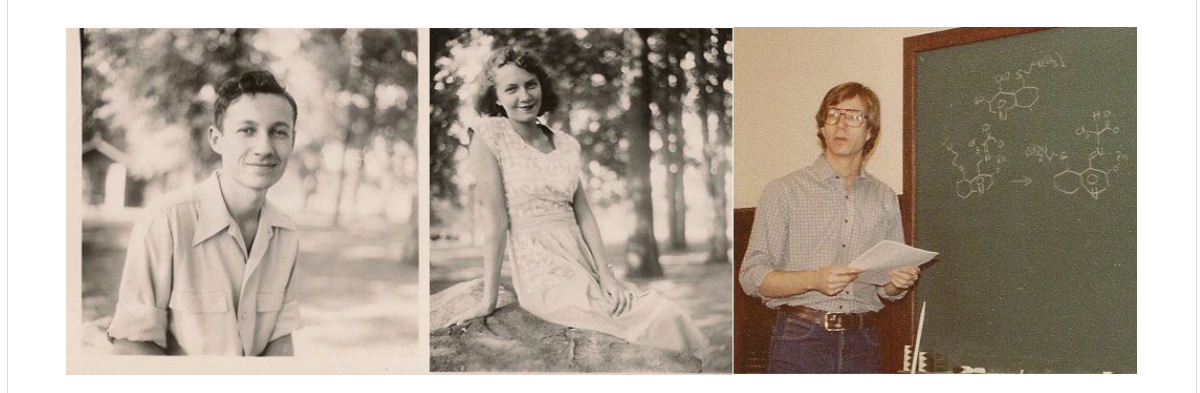
Figure 1: Photographs of Howard E. Zimmerman (July 5, 1926–February 12, 2012) (left) and Jane Zimmerman (née Kirschenheiter) (December 24, 1928–January 21, 1975) (center) as young adults, and the author (right) giving a Breslow group meeting presentation in graduate school (Havemeyer Hall, Columbia